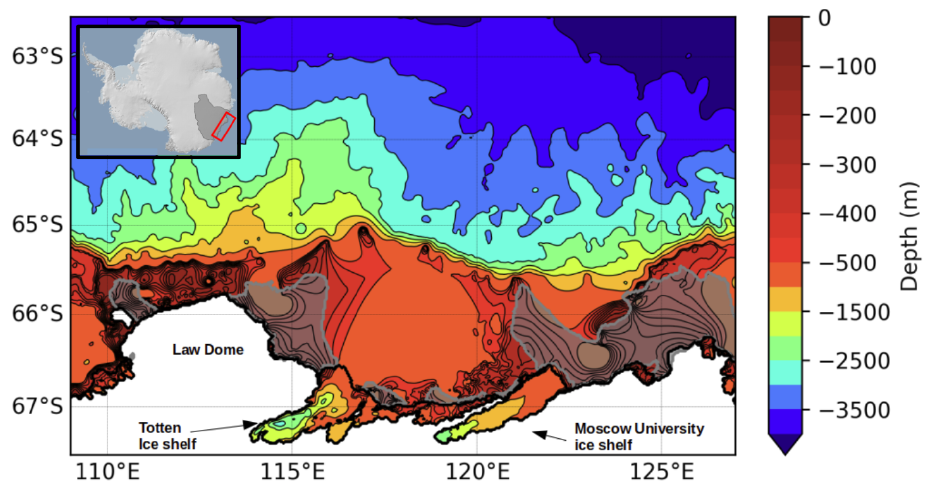
Figure 1. Model bathymetry and domain. The contour interval is 50 m up to 500 m depth and 500 m up to 4500 m depth. Ice shelf cavities are surrounded by a thick black line. The 0.75 fast ice observed frequency from [76] is shown by the shaded gray areas. The inset (top left) shows Antarctica with the model domain denoted by the grey area (ice sheet model domain) and by the red rectangle (ocean model